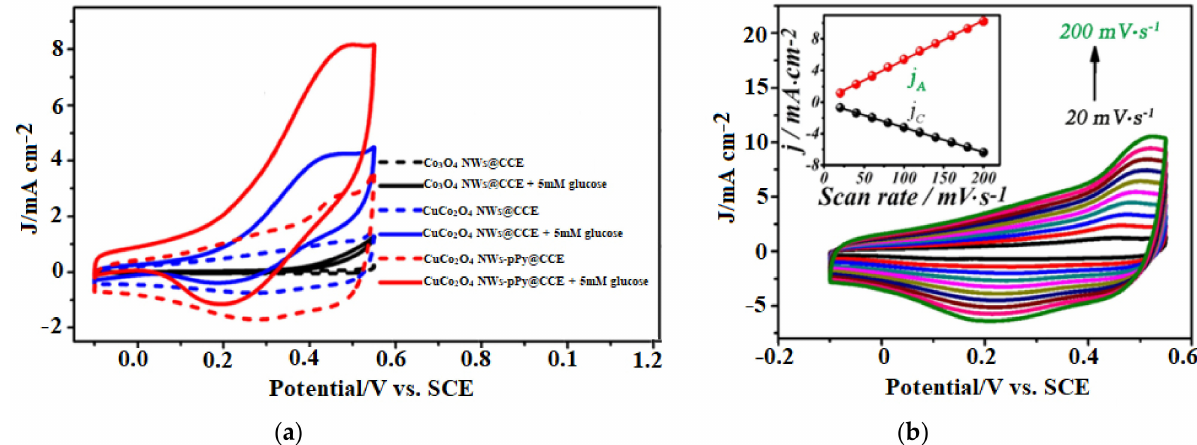
Figure 3. ( a ) The CV responses of different modified electrodes in 0.1 M NaOH at the scan rate of 20 mV · s − 1 in the presence and absence of 5 mM glucose. ( b ) The CV responses of CuCo 2 O 4 NWs-pPy@CCE at different scan rates from 20 to 200 mV · s − 1 in 0.1 M NaOH at the 20 mV · s − 1 scan rate in presence of 5 mM glucose. ( b ) Inset: The plot of peak current density versus square root of the scan rate.